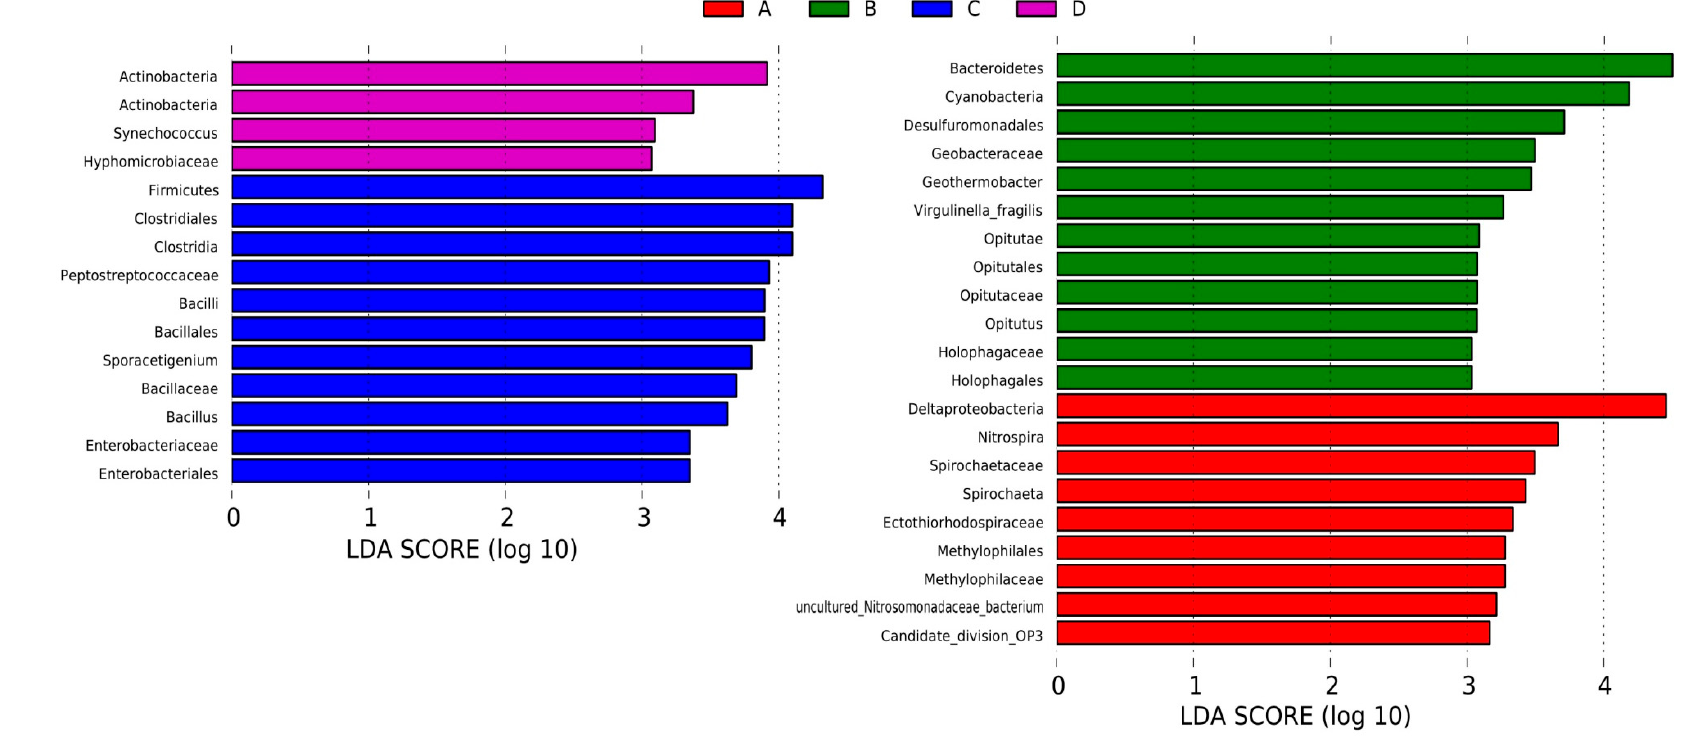
Figure 6. Indicator microbial groups within the four groups of sediments with LDA values higher than 3.0.